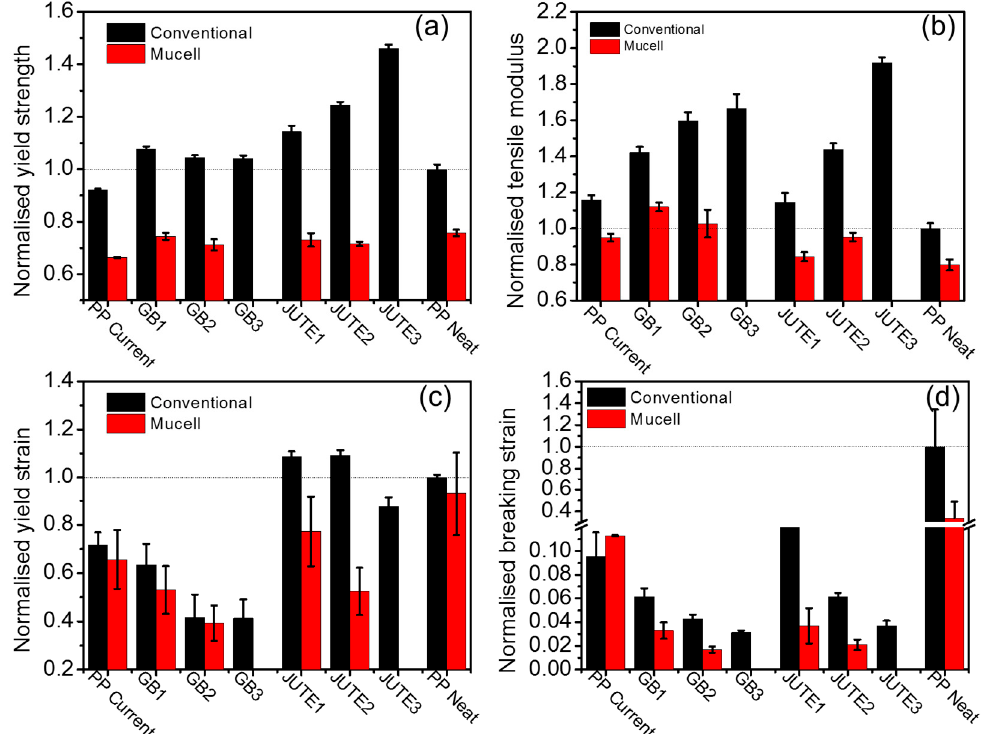
Figure 5. Normalised tensile properties of different materials: ( a ) yield strength; ( b ) tensile modulus; ( c ) yield strain; ( d ) breaking strain. Note: The data presented were normalised with respect to the corresponding data obtained for conventional injected PP Neat, indicated by the dashed line.